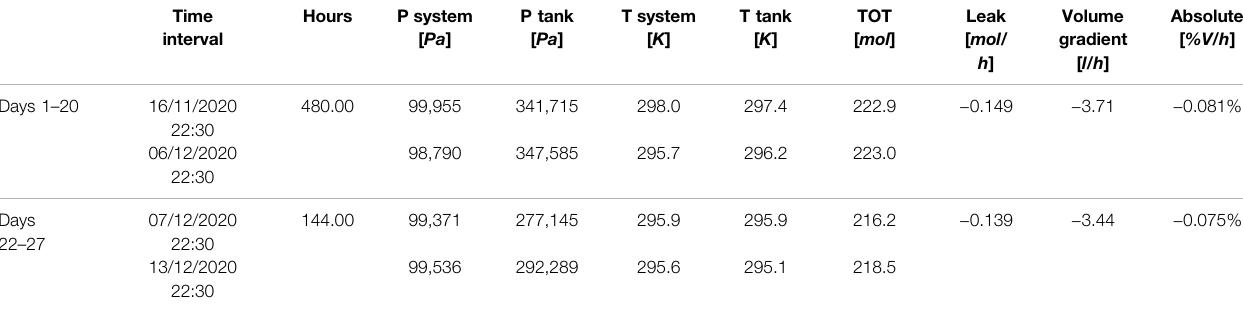
TABLE 4 | Total mass balance computation in terms of moles and % of volume during the 27 days life test on lettuce in the